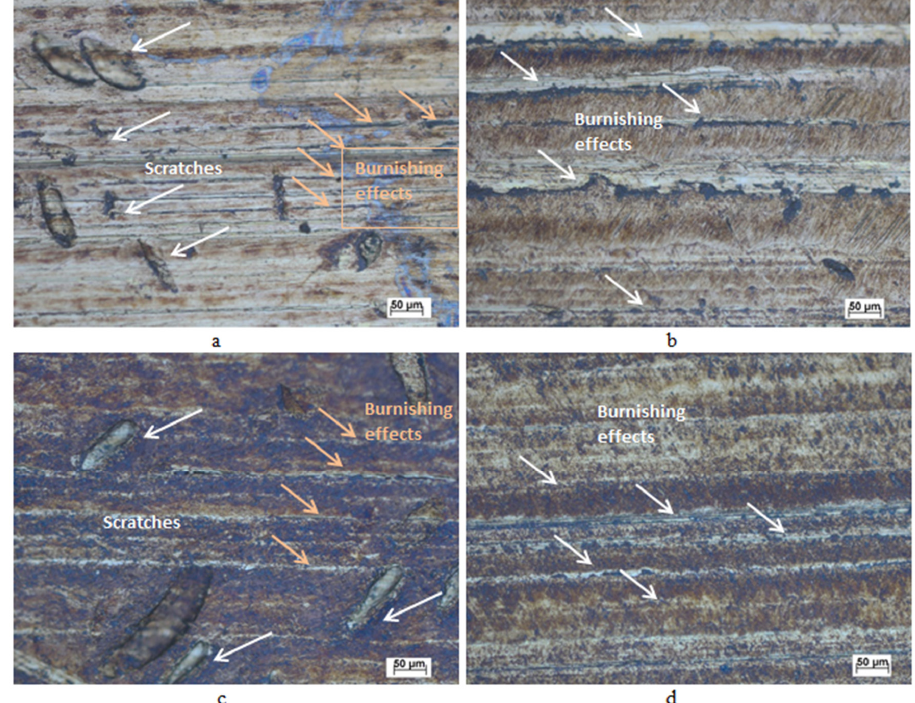
Figure 5. Top surface microscopy for 180-grit burnished surfaces at different passes and locations ( a ) A single pass 5 mm from the center; ( b ) a single pass 15 mm from the center; ( c ) four passes 5 mm from the center; ( d ) four passes 15 mm from the center.